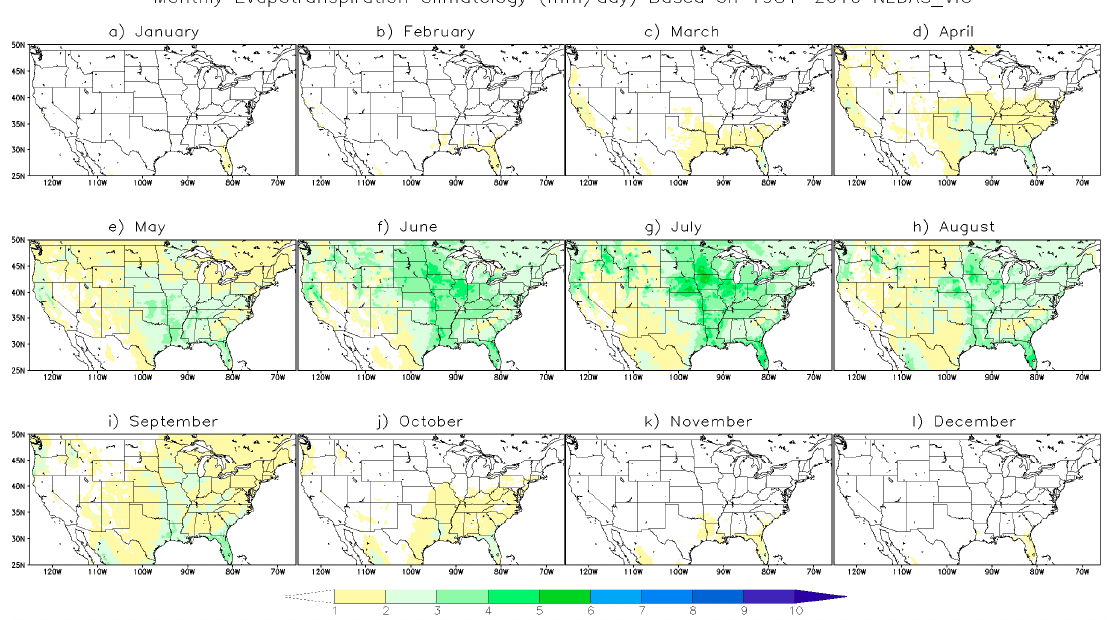
Figure 3. Monthly evapotranspiration climatology (mm/day) based on 1981–2010 North American Land Data Assimilation System (NLDAS-2) data.